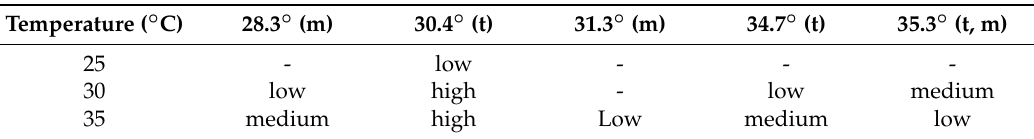
Figure 4. XRD patterns of crystalline ZrO 2 films grown on TiN substrates at different temperatures. The peaks assigned to tetragonal (t) and monoclinic (m) phases are indicated. Table 2. Intensities of XRD peaks corresponding to monoclinic (m) and tetragonal (t) phases observed for ZrO 2 films fabricated at different growth temperatures.